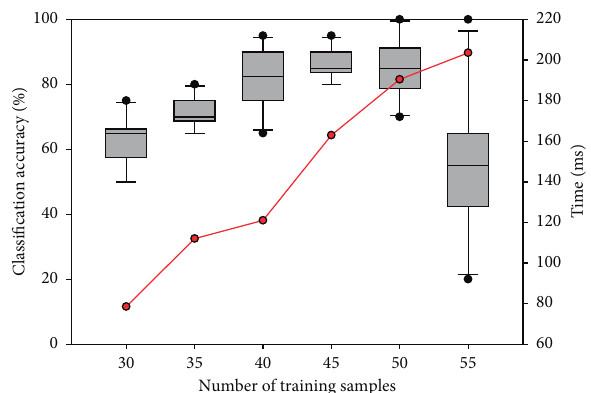
Figure 13: Classification results of different numbers of training sampling. Table 7: Parameters of other feature classification methods. Type